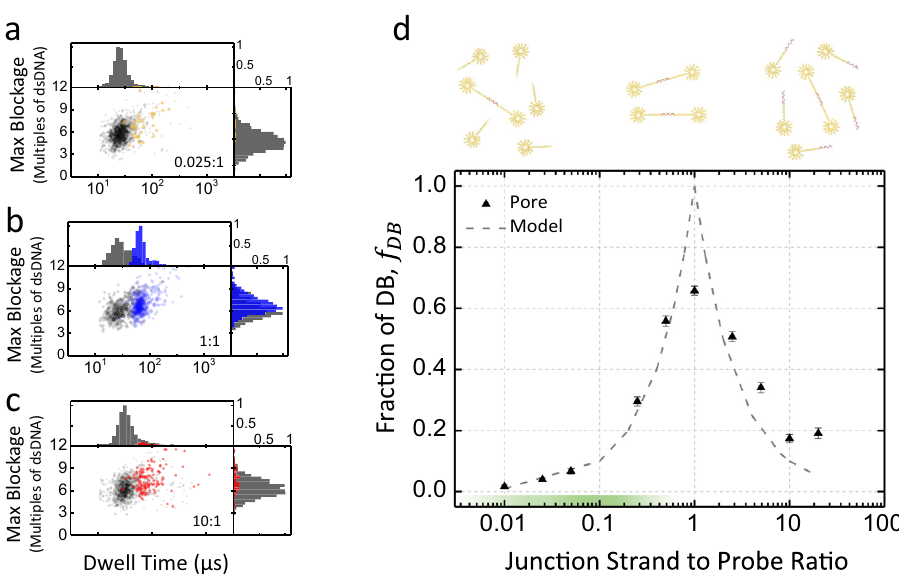
Fig. 3 Dose response of the junction strand-to-shooting star probes ratio from 0.01:1 to 20:1. a – c Scatter plots and histograms of maximum blockage versus dwell time (log scale), junction strand concentrations shown a) 500 pM (ratio 0.025:1); b 20 nM (ratio 1:1); and c 200 nM (ratio 10:1). Shooting star probes P-1 and P-2 are fi xed at 20 nM in all three cases. Dumbbell events called using the thresholding algorithm are shown in color, while probe events are shown in gray. d Linear dose response on a log scale for junction strand concentration ranging from 200 pM to 400 nM and shooting star probes fi xed at 20 nM, with ~1100 single-molecule events at each concentration. Dashed line depicts prediction from model of binding kinetics. The optimal operating range (0.01 – 0.5) is highlighted in green on the x -axis. Experiments are performed in 3.2 M LiCl pH 8, at 100 mV using a 12 nm pore, with the analysis threshold set to 2.5x dsDNA all experiments are low-pass Bessel fi ltered at 200 kHz for analysis. Error bars are calculated as described in Eq. 3. Source data are available as a Source Data fi